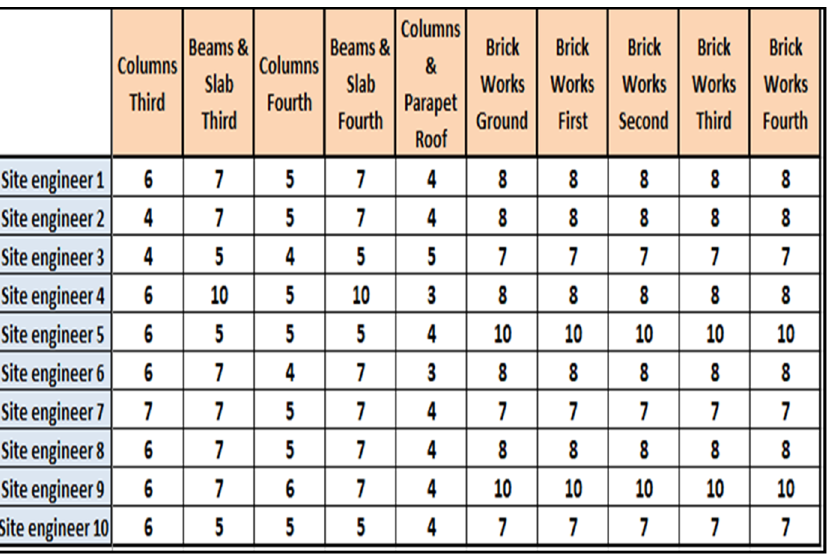
Figure 11. The approximate durations of each activity based on site engineer experiences in similar projects.